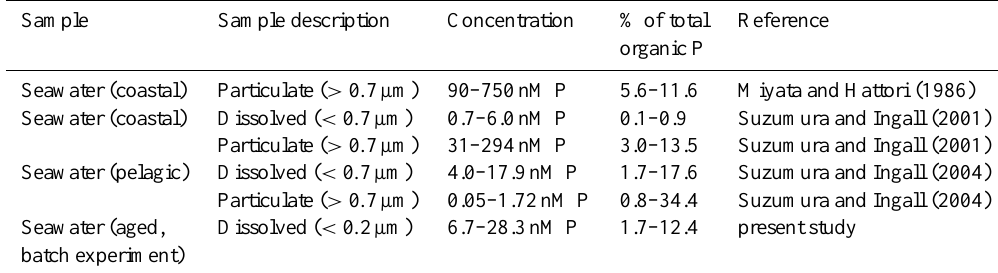
Table 3. Lipid P concentrations and percentages of total organic P as shown by Suzumura (2005).